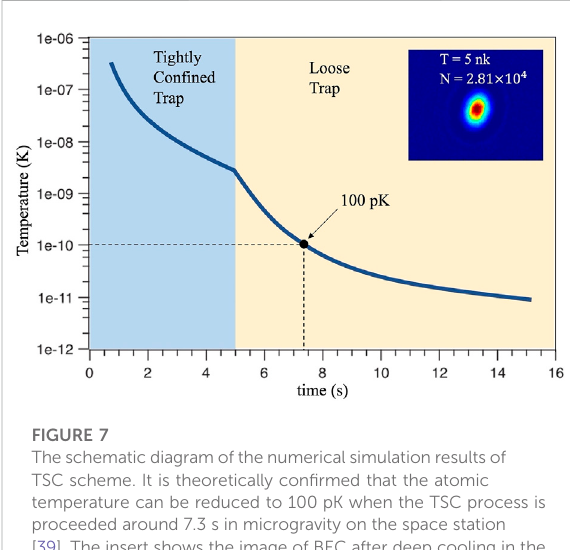
FIGURE 7 The schematic diagram of thenumerical simulation results of TSC scheme. It is theoretically con fi rmed that the atomic temperature can be reduced to 100 pK when the TSC process is proceeded around 7.3 s in microgravity on the space station [39]. The insert shows the image of BEC after deep cooling in the ground veri fi cation experiments. The equivalent temperature of BEC is T = 5 pK and the number of 87 Rb atoms is n = 2 . 81 × 10 4